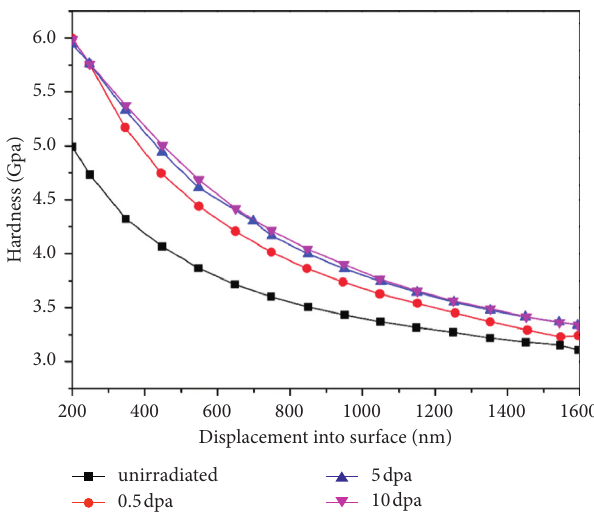
Figure 10: Variation curve of the hardness of Hastelloy N alloy specimen before and after ion irradiation.